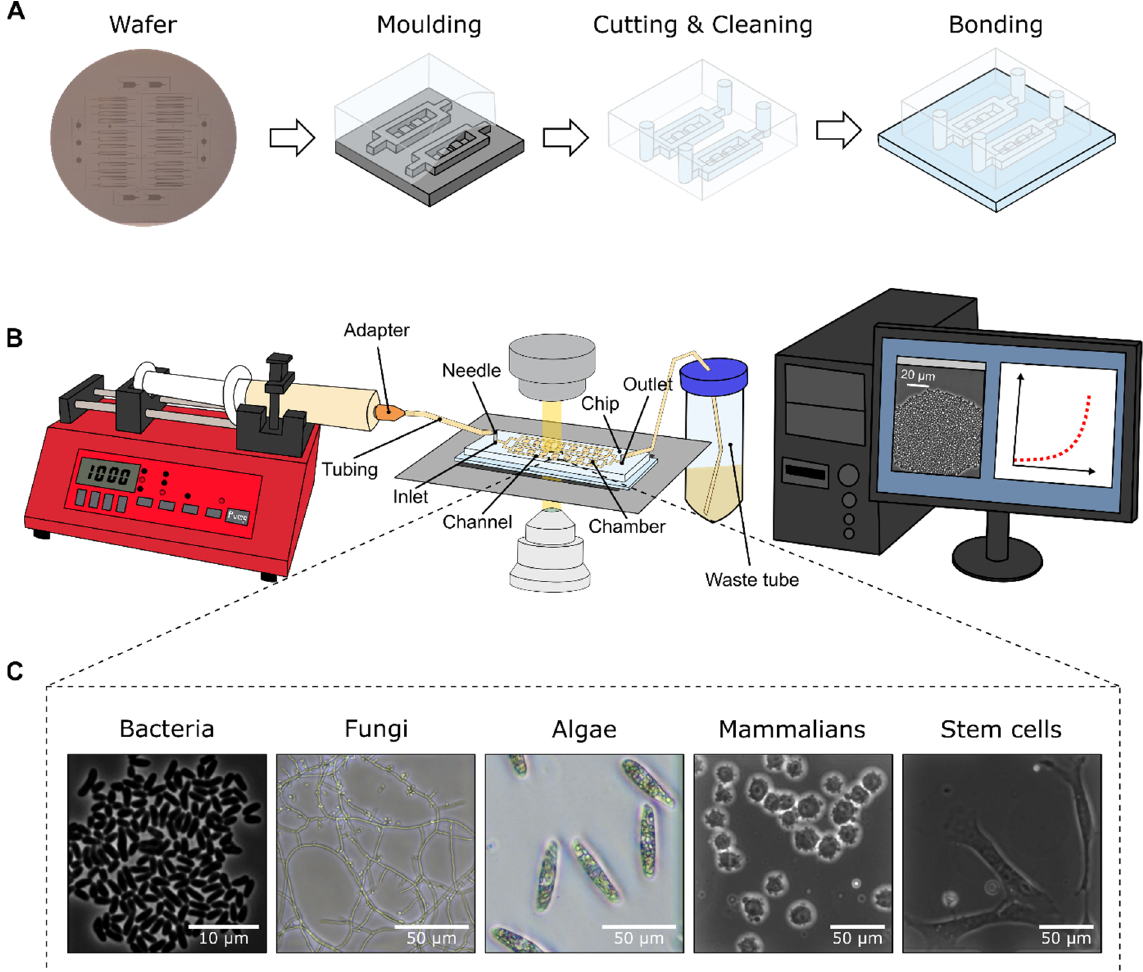
Figure 1. Overview of a microfluidic cultivation (MC) experiment. ( A ) Fabrication of a MC device: moulding a silicon wafer with PDMS, cutting, and cleaning the resulting PDMS chip, bonding of the PDMS chip with a glass substrate. ( B ) Experimental setup with a live ‐ cell imaging microscope for time ‐ lapse microscopy under constant environmental conditions. ( C ) Overview of different organisms, namely bacteria, fungi, algae, mammalian suspension cells as well as adherent human stem cells, that have been analysed using MC so far.